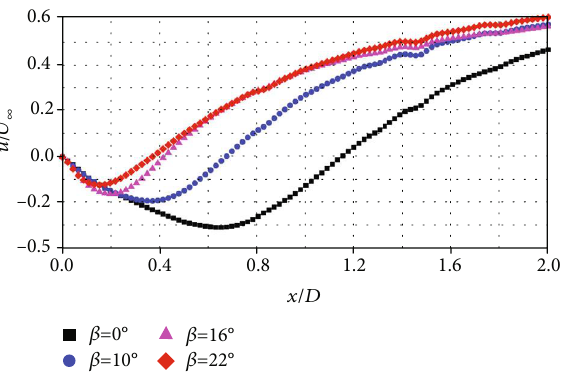
Figure 7: Velocity at the centerline.